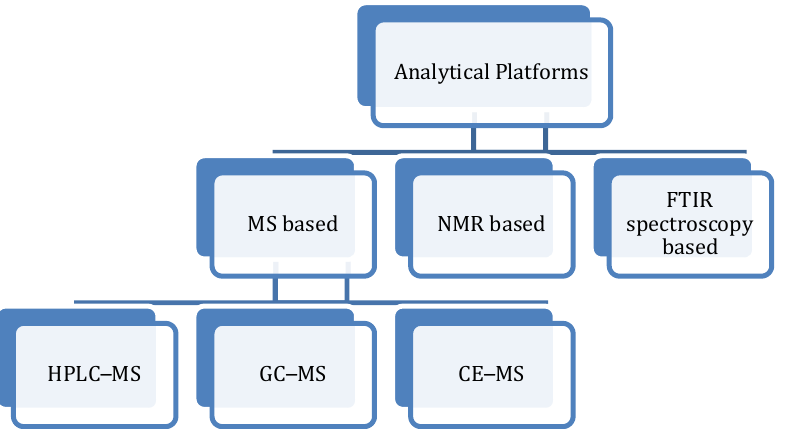
Figure 2. Summary of the major analytical platforms for metabolomic studies in human and animal samples. The figure depicts the three most often employed platforms for metabolomic studies—MS, NMR, and FTIR spectroscopy. The MS-based approach involves coupling with liquid chromatography (LC), gas chromatography (GC), or capillary electrophoresis (CE).